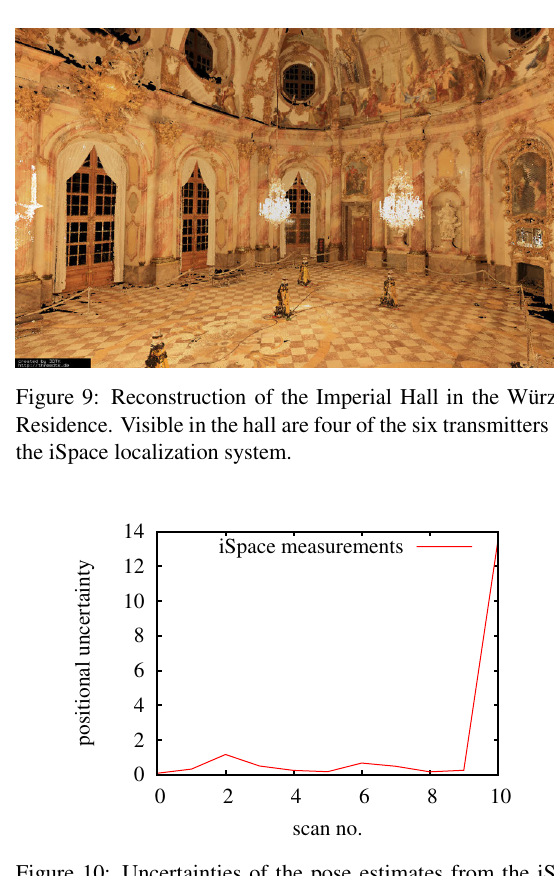
Figure 10: Uncertainties of the pose estimates from the iSpace localization system.